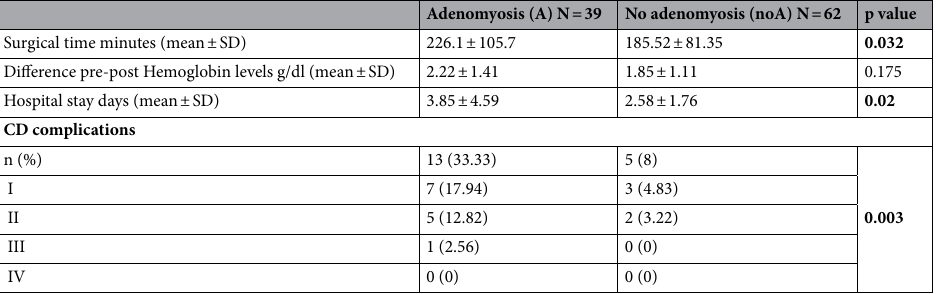
Table 5. Surgical data considering patients without hysterectomy. Significant values are in bold. Data are given as n or %. SD standard deviation, CD Clavien–Dindo, n number, %